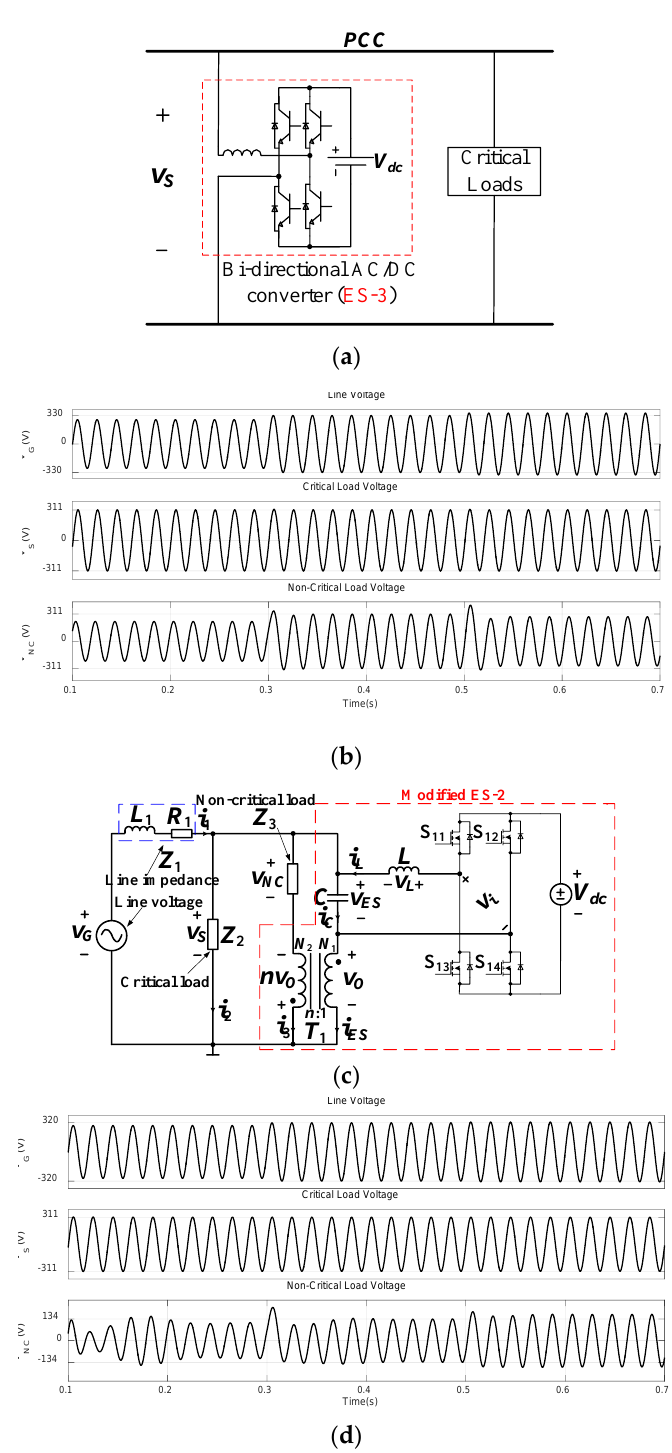
Figure 6. ES-3 and comparisons between ES-2 and Modified ES-2. ( a ) ES-3 and its application circuit; ( b ) Waveforms of ES-2; ( c ) Circuital scheme of Modified ES-2; ( d ) Waveforms of Modified ES-2.